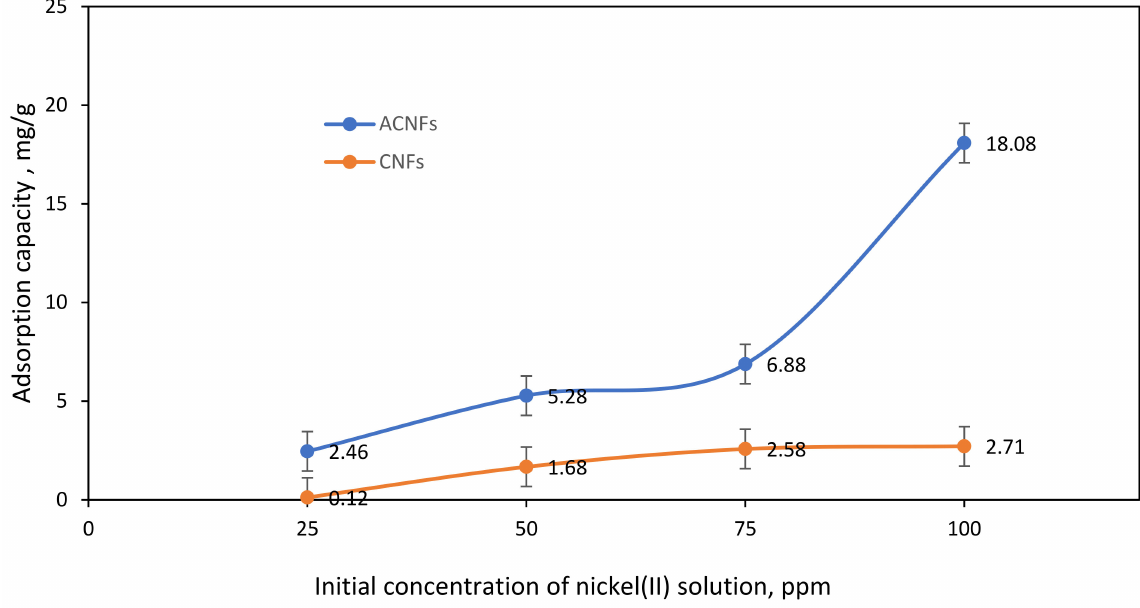
Figure 8. Effect of initial concentration on adsorption capacity of Ni(II) ions for ACNFs and CNFs. Condition: Solution pH = 3, Adsorbent dosage = 50 mg, contact time = 60